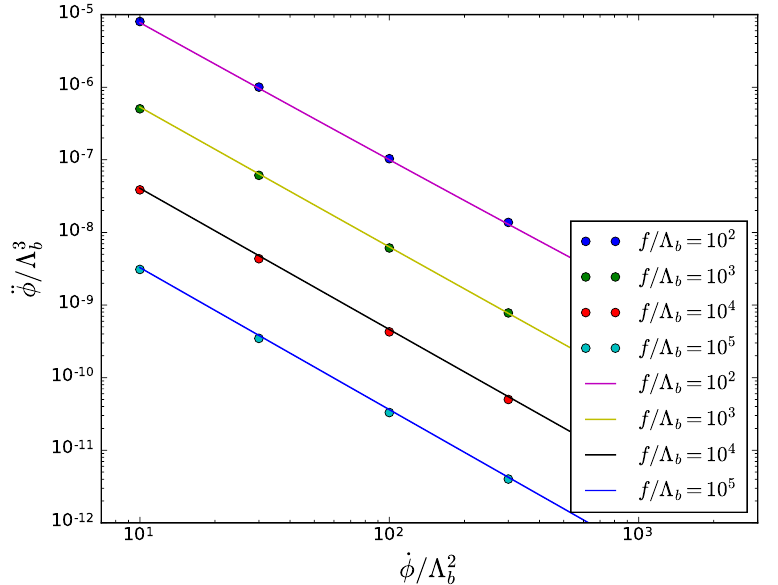
Figure 12 . (cid:127) (cid:30) as a function of _ (cid:30) with (cid:22) 3 = 0 and H = 0. The lines are obtained from eq. (3.24). The dots are calculated from the numerical solution of eqs. (2.9) and (2.10).